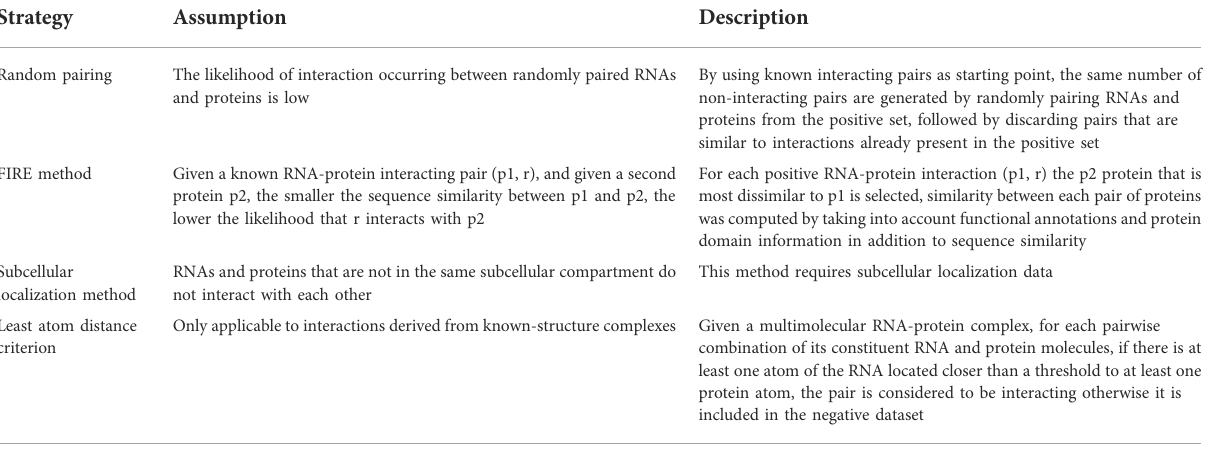
TABLE 5 Strategies for the construction of a negative dataset for RNA-protein interaction prediction.